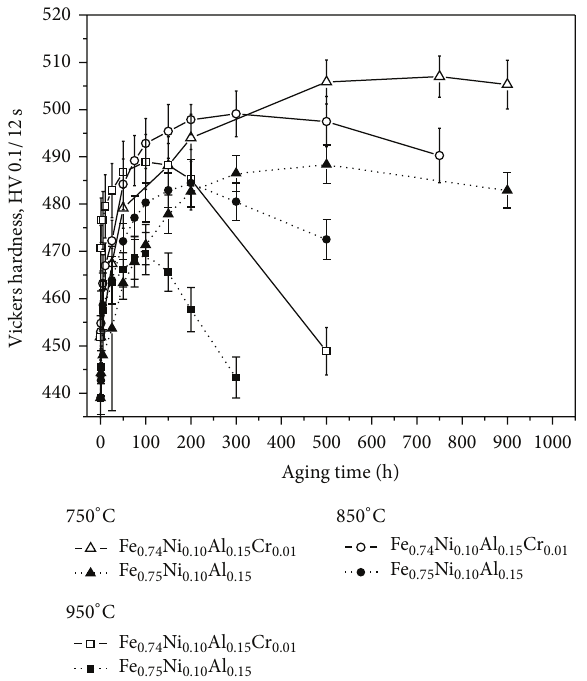
Figure 8: Aging curves for the Fe 0.75 Ni 0.10 Al 0.15 and Fe 0.74 Ni 0.10 Al 0.15 Cr 0.01